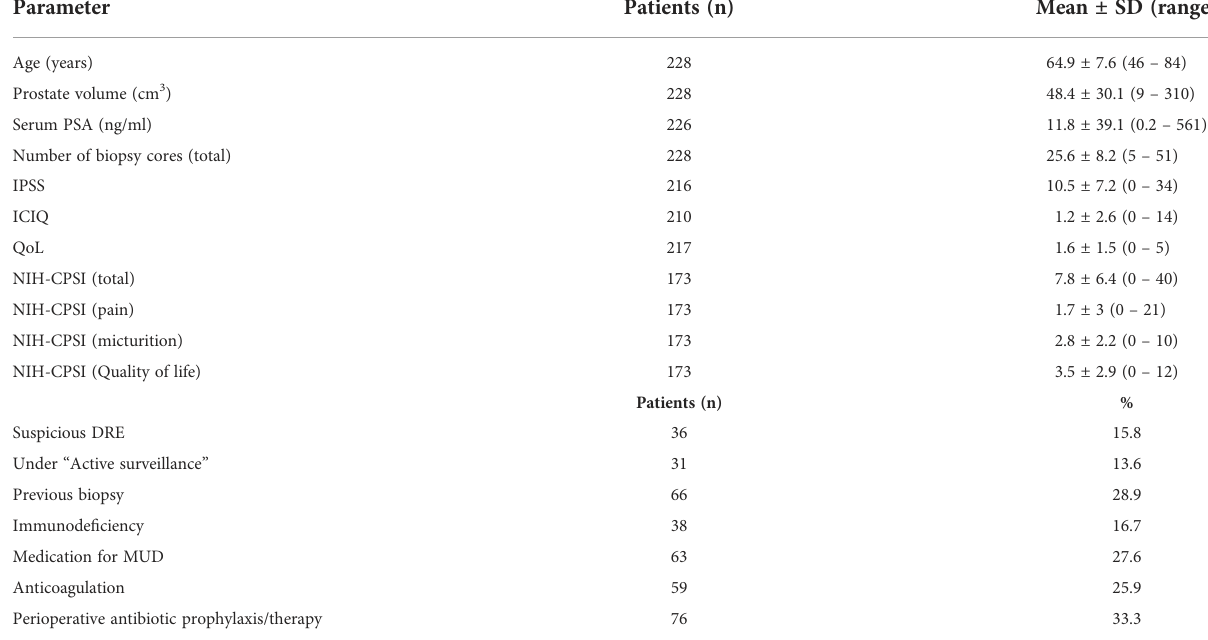
TABLE 1 Baseline